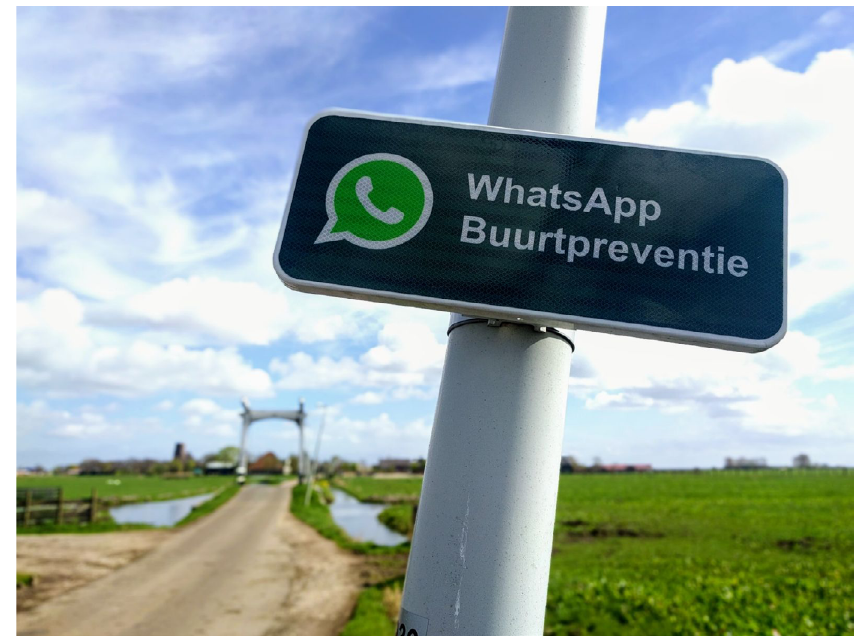
Figure 1. Neighbourhood Watch (‘Buurtpreventie’) sign on the outskirts of Amsterdam (Photo: Antal